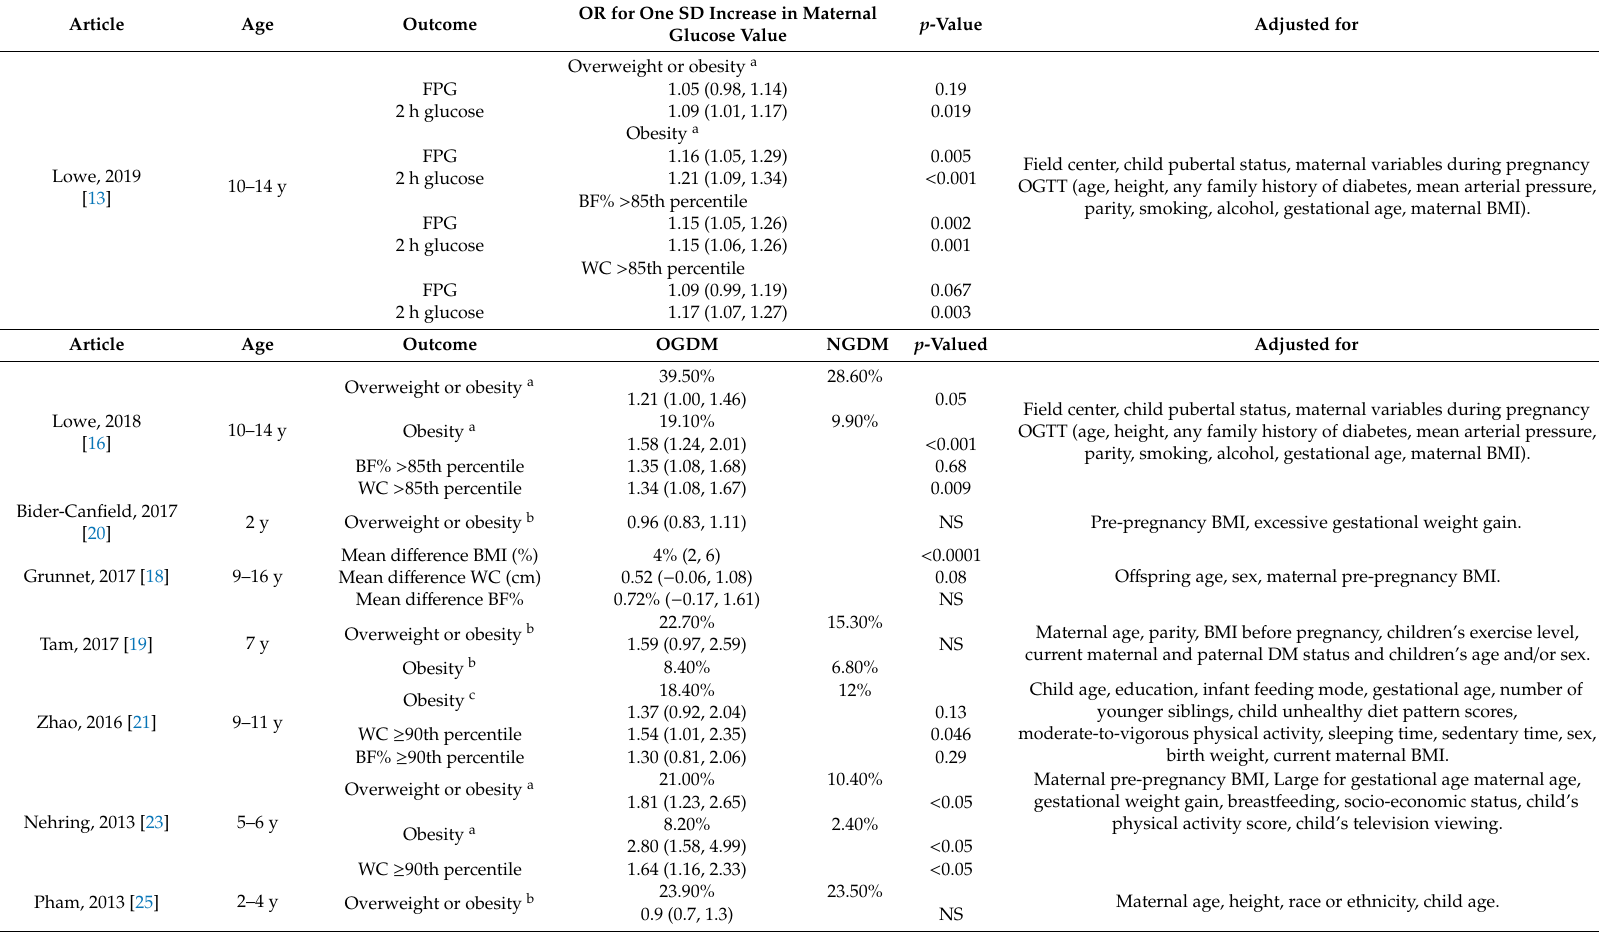
Table 2. The impact of GDM on overweight and adiposity in the o ff